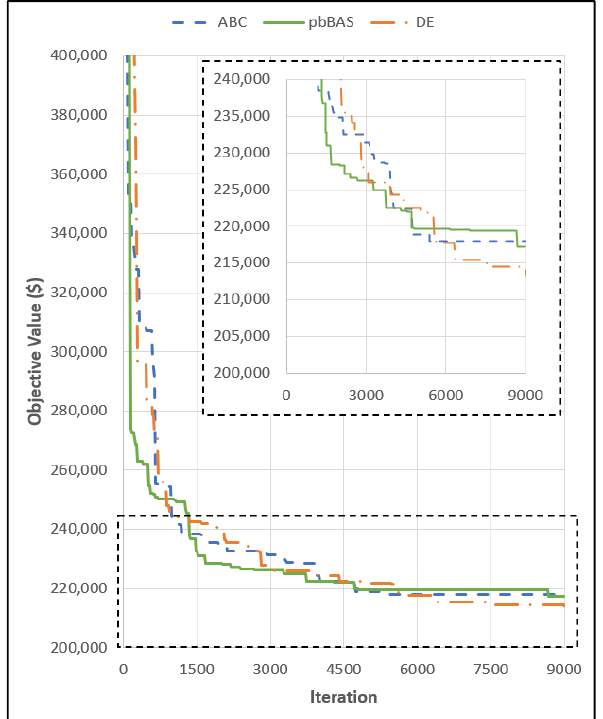
Figure 20. Design history of the worst run achieved by each metaheuristic algorithm for the three- segment type folded plate roof problem.